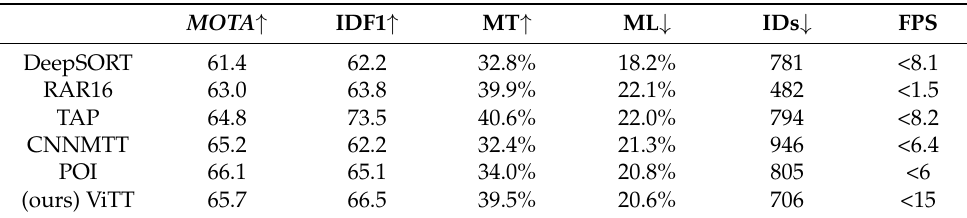
Table 1. Comparison with the standard online trackers under the private detections protocol on the MOT-16 benchmark. The arrows indicate low or high optimal metric values.